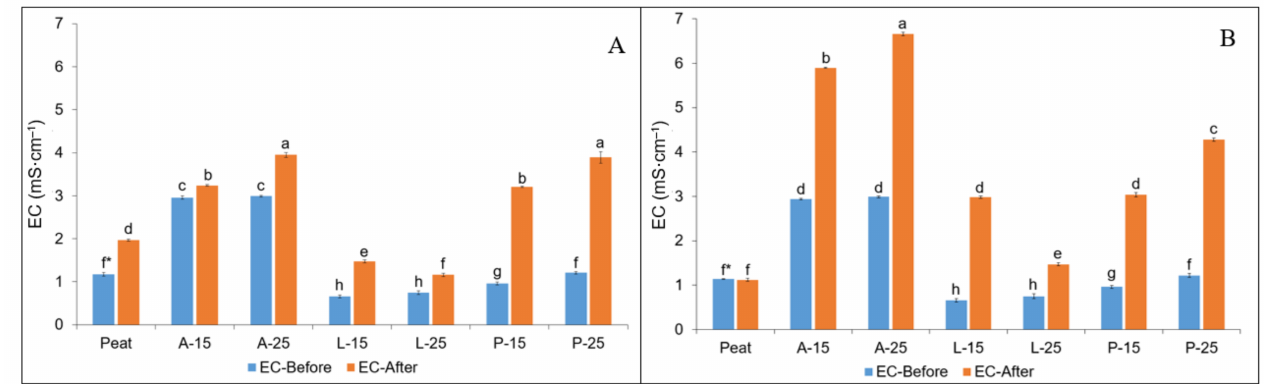
Figure 2. Substrate EC before and after strawberry cultivation in autumn ( A ) and spring ( B ) planting as influenced by substrates; * means followed by the same letters are not significantly different at p < 0.05 according to Tukey’s HSD ( n =